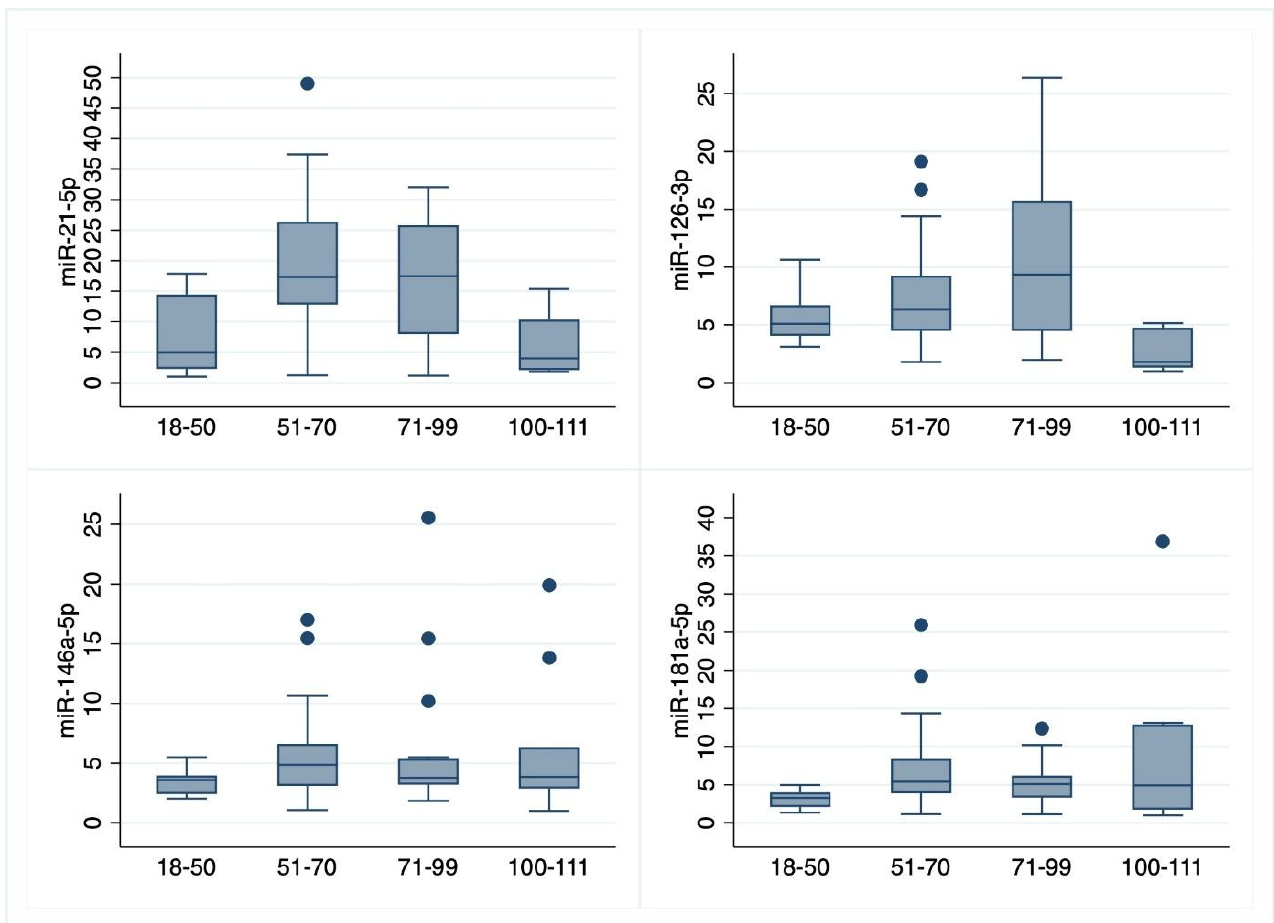
Figure 1. Box-and-Whisker plots of miRNAs levels by class of age. Box-and-Whisker plots report minimum, quartiles (q 1 , q 2 and q 3 ) and maximum levels of each miRNA by age class. The individual points (or dots) plotted are outliers. The spacings between different parts of the box indicate dispersion and skewness in the data and shows a graphical measure of interquartile range (q 3 –q 1 ) and range (max-min).